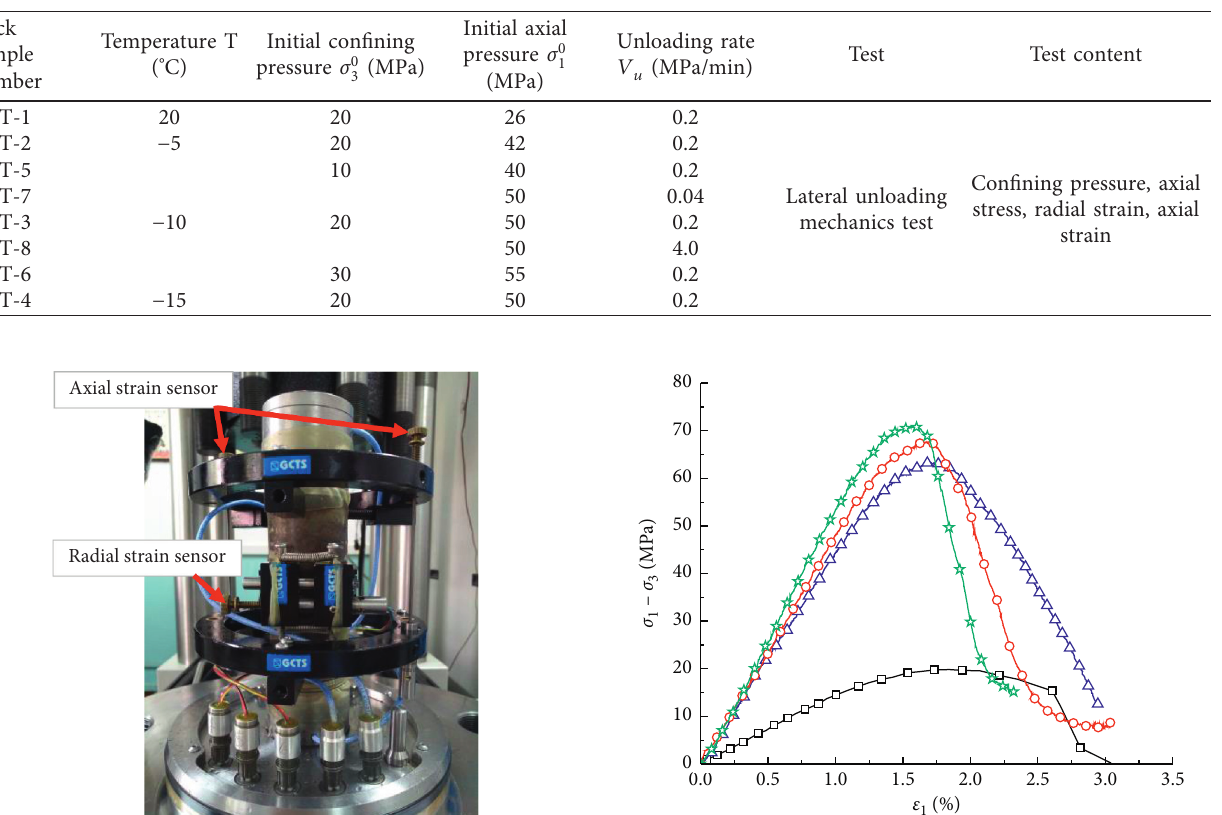
Table 1: Lateral unloading test plan.